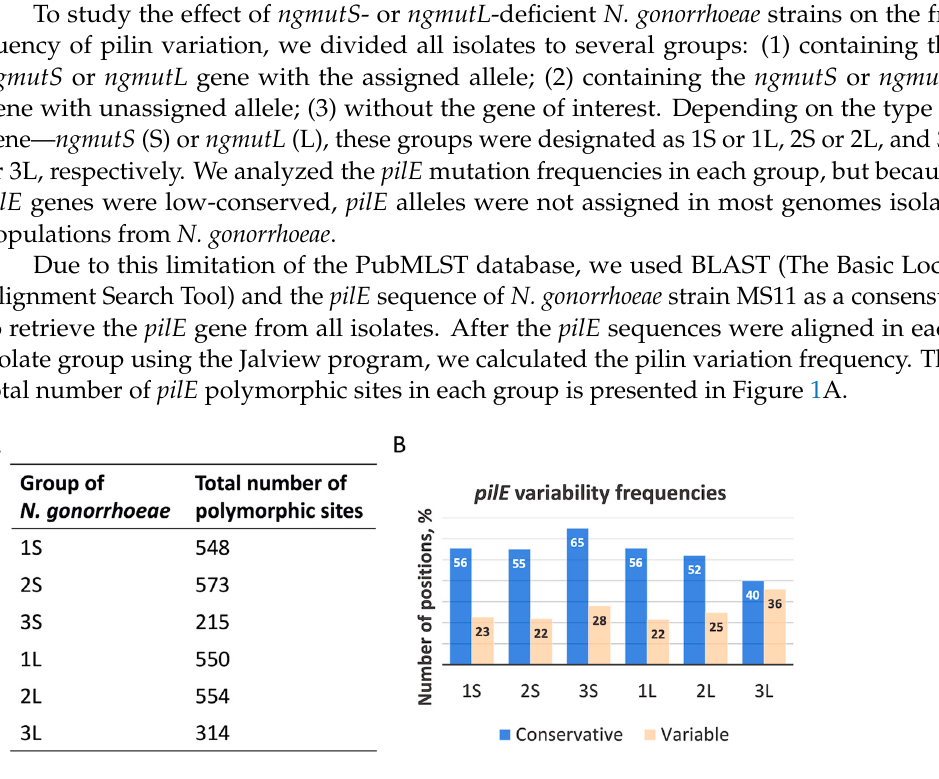
Figure 1. Polymorphism of pilE in groups of all N. gonorrhoeae isolates. Total number of pilE polymorphic sites ( A ). Number of pilE positions with specific nucleotide substitutions in each group of N. gonorrhoeae isolates as the ratio of conservative (<10%) or variable (>25%) substitutions to the total alignment length ( B ). Data are presented as a percentage.